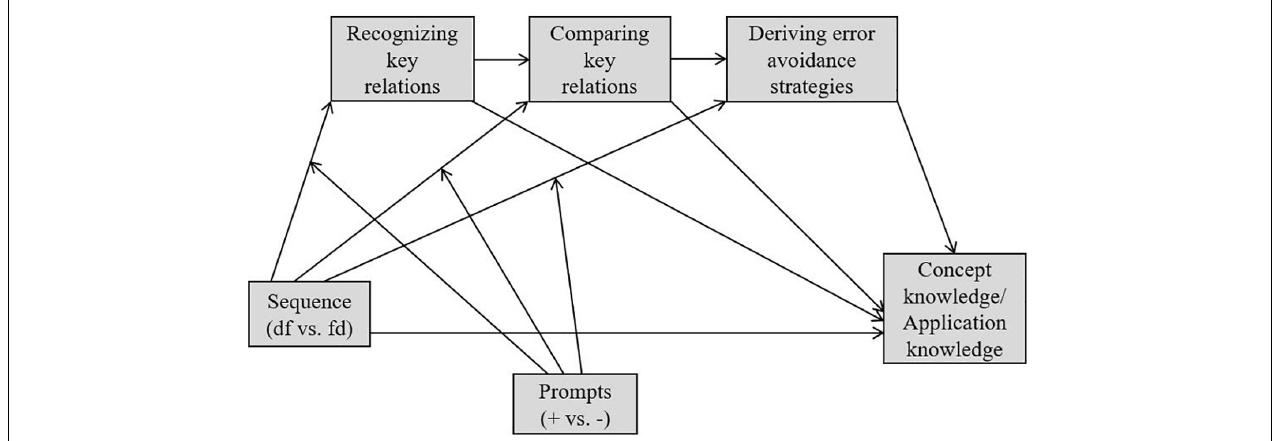
FIGURE 1 | The conceptual regression model (Hypothesis 4). df, dysfunctional-functional; fd, functional-dysfunctional.